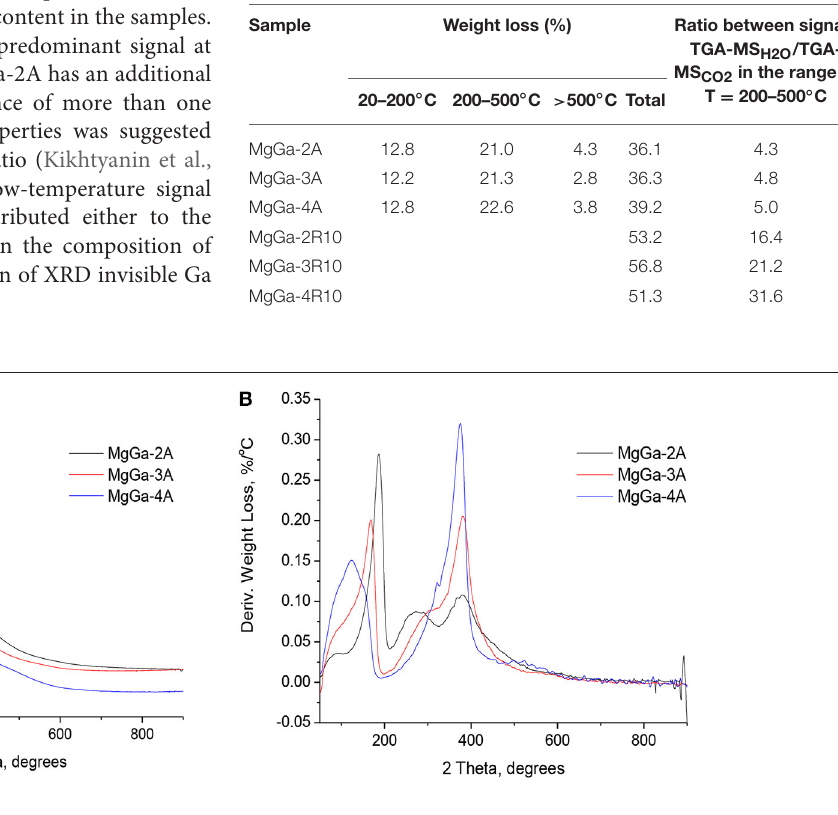
Frontiers in Chemistry |